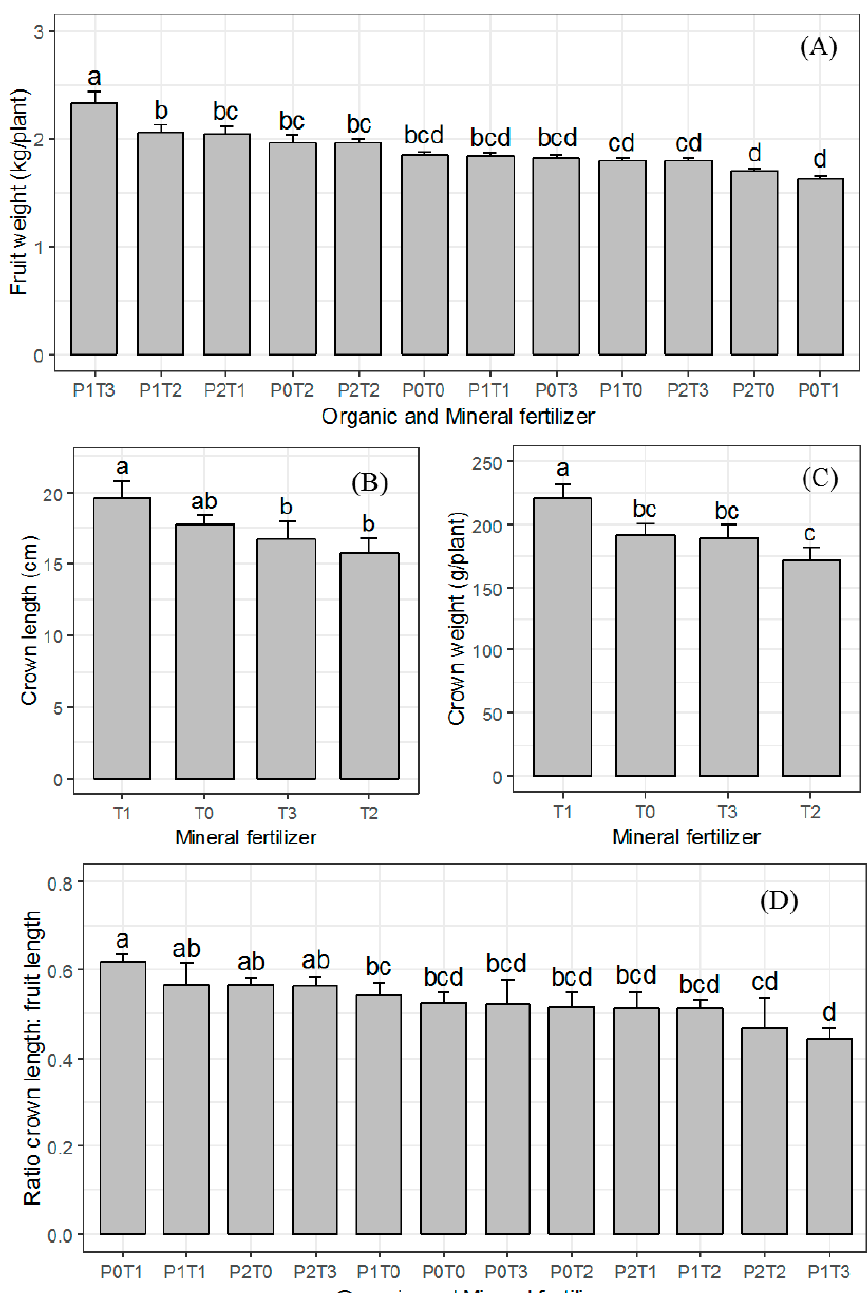
Figure 1. Effect of organo-mineral fertilizer on average: ( A ) fruit weight; ( B ) crown length; ( C ) crown weight, and ( D ) ratio crown length: fruit length. T0: = 100 N-30 P-150 K, T1: 200 N-60 P-300 K, T2: 400-120-600, and T3: 600-180-900 (kg ha − 1 ), P0T0: 0 t ha − 1 of poultry litter and N-P-K in Kg ha − 1 100-30-150, P0T1: 0 t ha − 1 of poultry litter and N-P-K in Kg ha − 1 200-60-300, P0T2: 0 t ha − 1 of poultry litter and N-P-K in Kg ha − 1 400-120-600, P0T3: 0 t ha − 1 of poultry litter and N-P-K in Kg ha − 1 600-180-900, P1T0: 5 t ha − 1 of poultry litter and N-P-K in Kg ha − 1 100-30-150, P1T1: 5 t ha − 1 of poultry litter and N-P-K in Kg ha − 1 200-60-300, P1T2: 5 t ha − 1 of poultry litter and N-P-K in Kg ha − 1 400-120-600, P1T3: 5 t ha − 1 of poultry litter and N-P-K in Kg ha − 1 600-180-900, P2T0: 10 t ha − 1 of poultry litter and N-P-K in Kg ha − 1 100-30-150, P2T1: 10 t ha − 1 of poultry litter and N-P-K in Kg ha − 1 200-60-300, P2T2: 10 t ha − 1 of poultry litter and N-P-K in Kg ha − 1 400-120-600, P2T3: 10 t ha − 1 of poultry litter and N-P-K in Kg ha − 1 600-180-900.